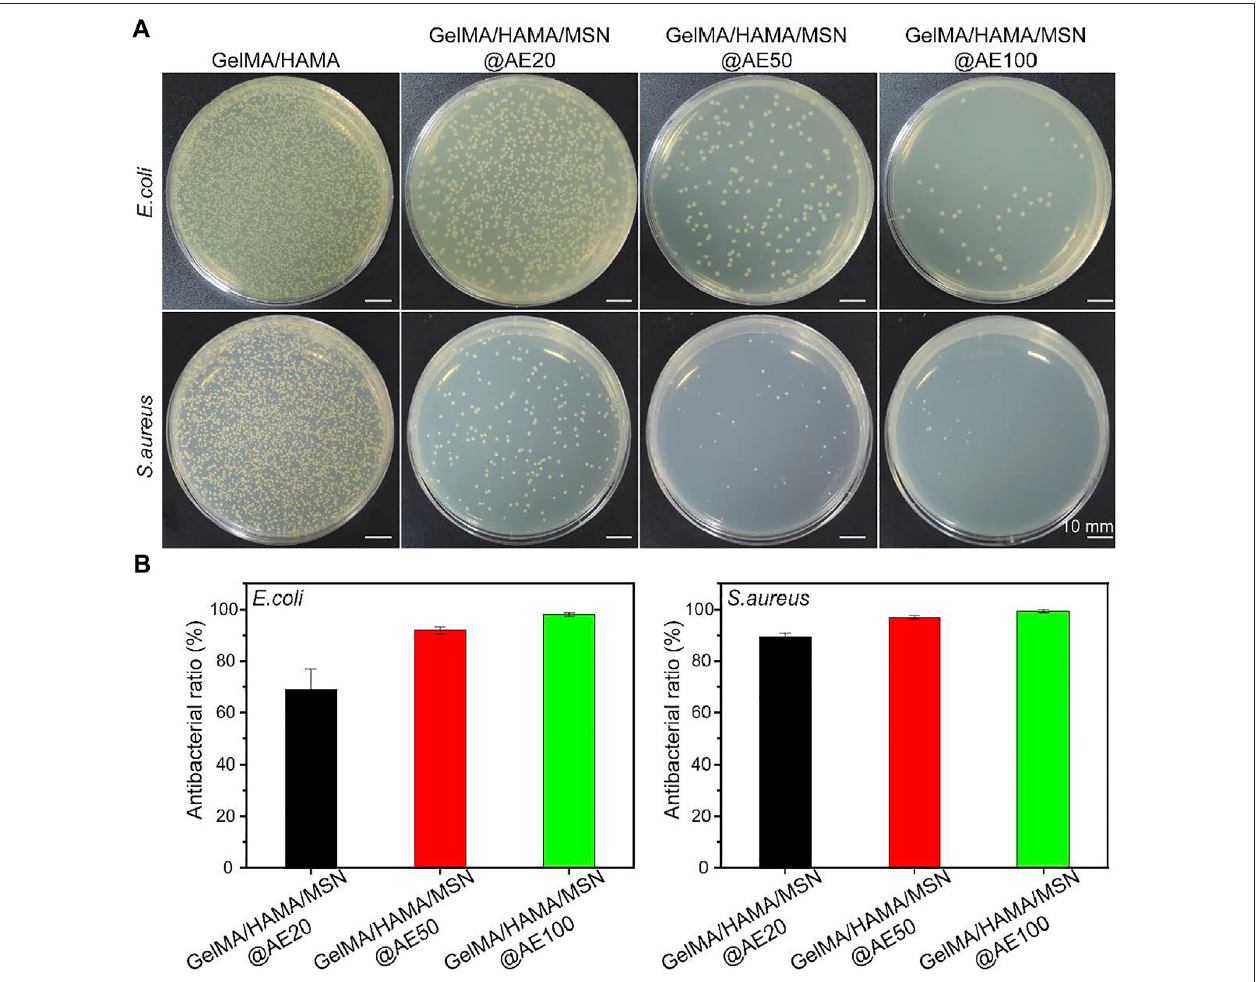
FIGURE 3 | (A) Bacterial colonies of E. coli and S. aureus after coculture with GelMA/HAMA/MSN@AE hydrogel with different AE concentrations. (B) Antibacterial rate of E. coli and S. aureus